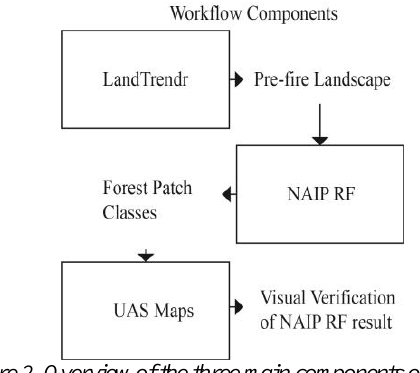
Figure 2. Overview of the three main components of